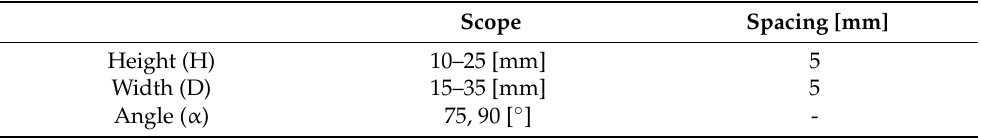
Table 2. Range of geometric dimensions of the hexagonal cut-out